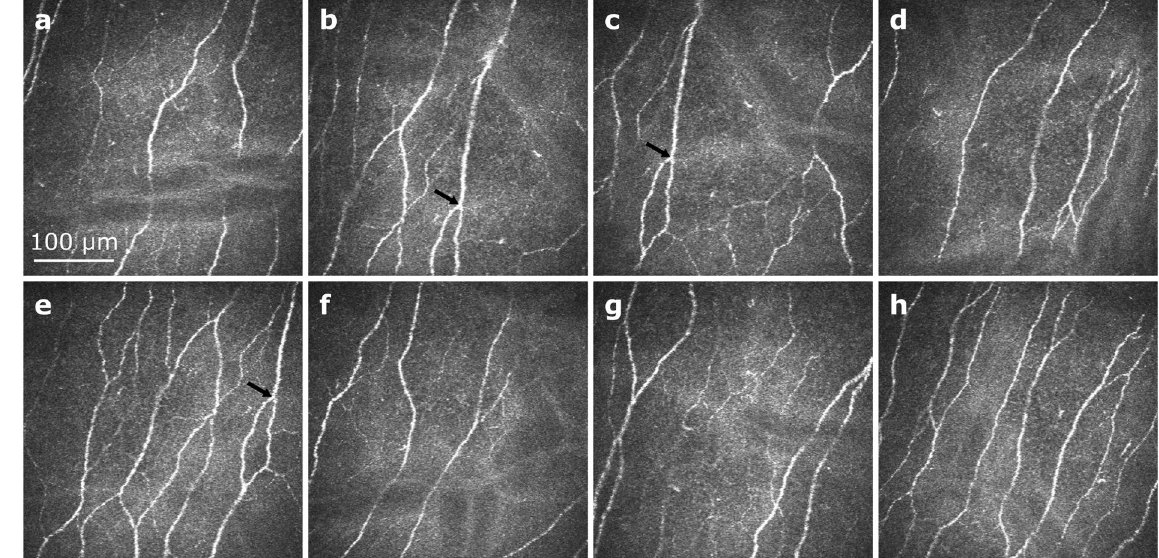
Figure 7. Exemplary sample of eight CCM images of the SNP manually selected from the dataset used for Fig. 5 (subject 8, examination E2, 1246 images total). Repeated presence of the same SNP region in multiple images (as for example in subfigures ( b , c , e ) see black arrows) can potentially introduce bias effects to morphometric parameter measurements and should therefore be avoided; identification of such repeatedly represented SNP regions in a manual image selection procedure is not